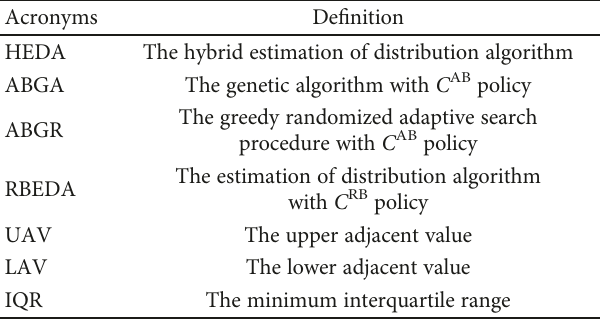
Table 5: Acronym de fi